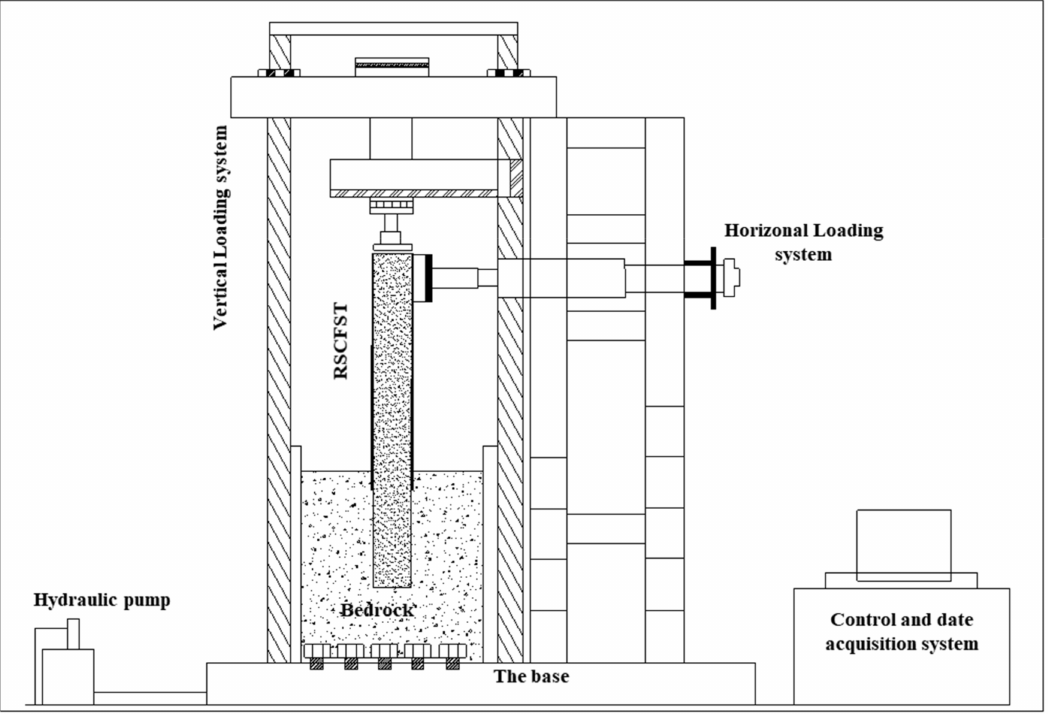
Figure 3. Test loading